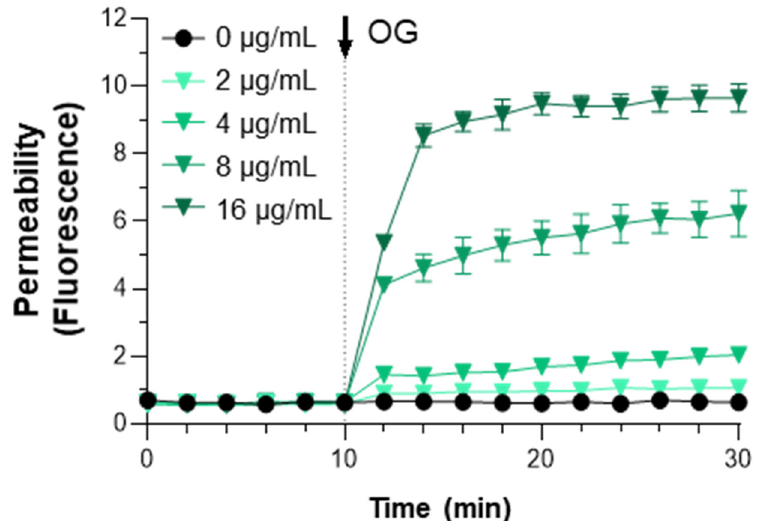
Figure 2. Alterations in cell wall permeability in MRSA by octyl gallate (OG). The permeability was measured with propidium iodide. The arrow indicates the time point when OG was added to bacterial suspensions. The results show the means and standard deviations of fluorescence values from three samples in a single experiment. The experiment was repeated three times and produced similar results.